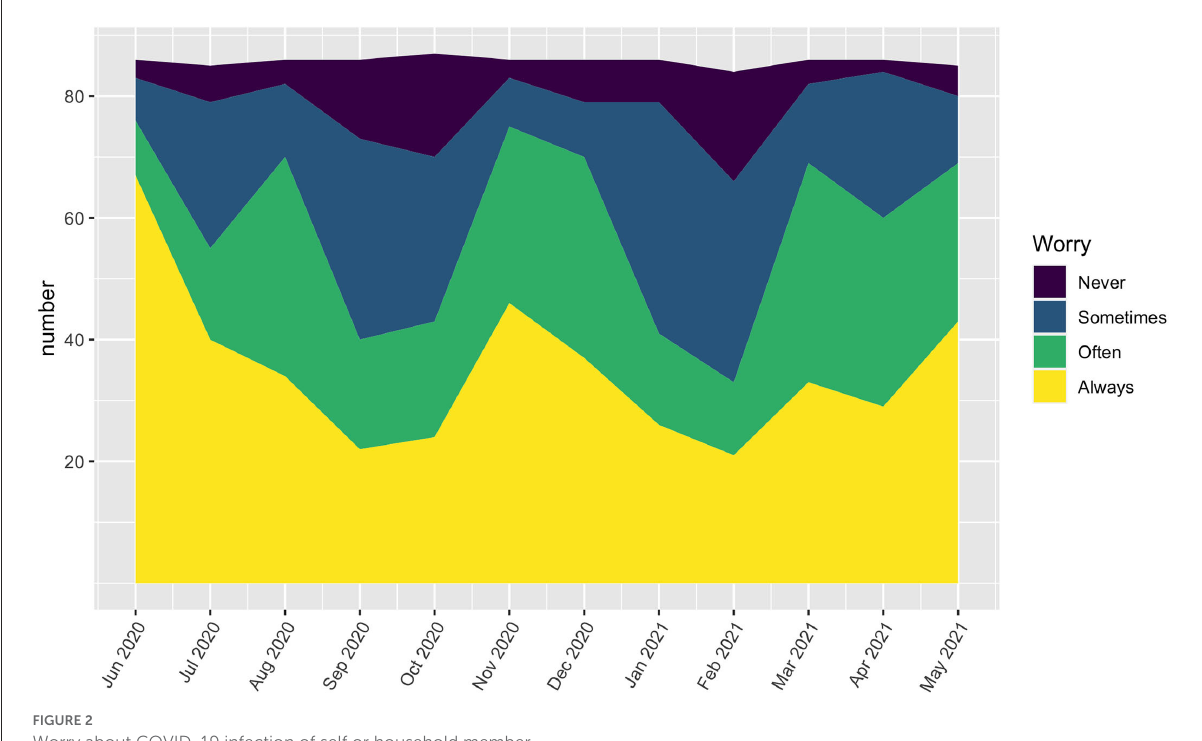
FIGURE2 Worry about COVID-19 infection of self or household member.